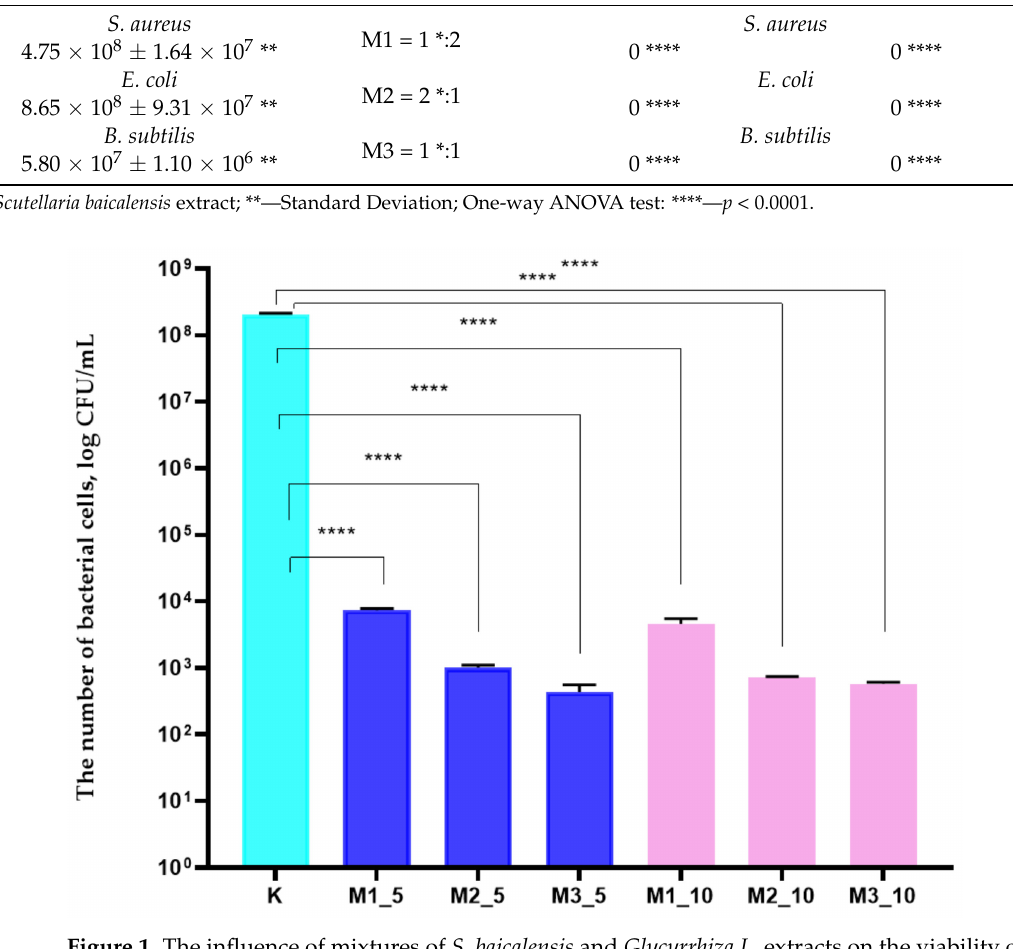
Mixture of Extract Concentration [%] Ratio of the Mixture The Number of Bacterial Cells after Incubation with Mixtures of Extracts [CFU/mL]